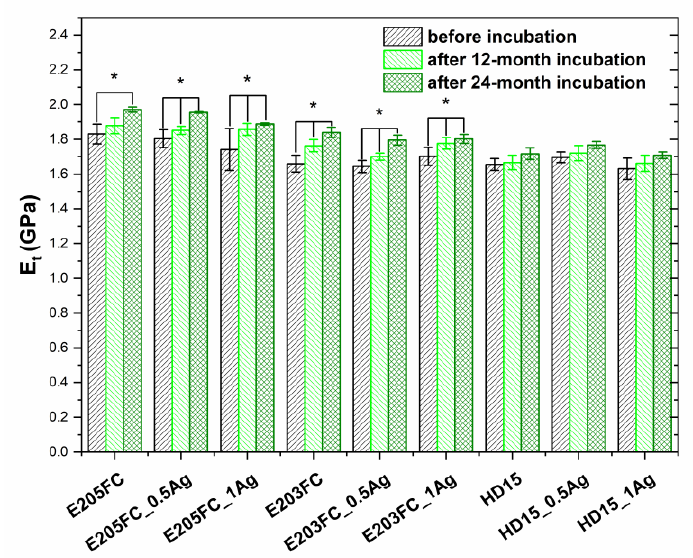
Figure 7. Young modulus ( E t ) of pure polymers and polymers containing 0.5 wt % and 1.0 wt % of silver nanoparticles AgNPs. Statistically significant differences ( p < 0.05) between materials before and after 12- and 24-month incubation are indicated by asterisk (*).